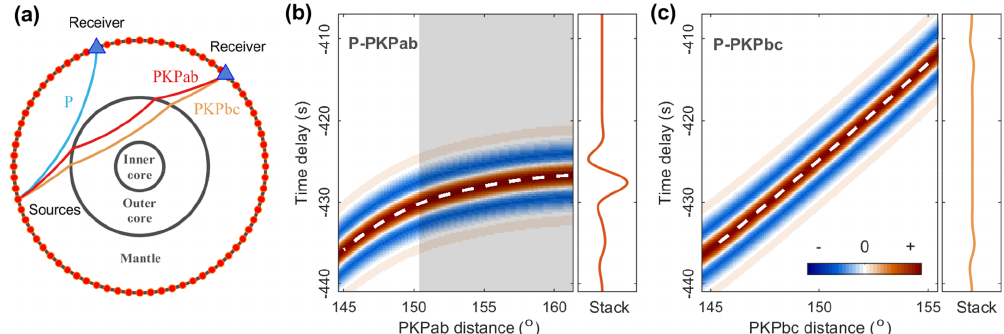
Figure 9. (a) Geometry of the model to synthesize the inter-receiver correlation function of teleseismic P and PKP waves via source averag- ing. (b) Source-averaging experiment for the P–PKPab correlations at an inter-receiver distance of 63 ◦ . The source-wise P–PKPab correlation functions are synthesized by convolving a 6.2s period wavelet with the P–PKPab time delays. The final inter-receiver correlation function is